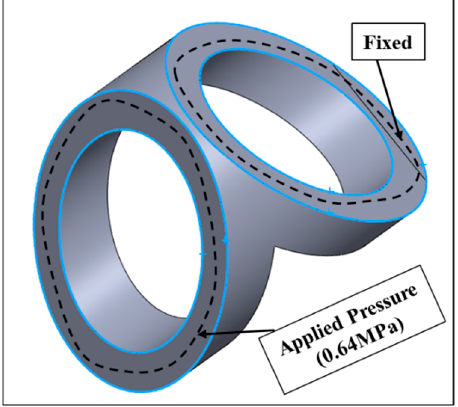
Figure 4. Boundary conditions of the splint .